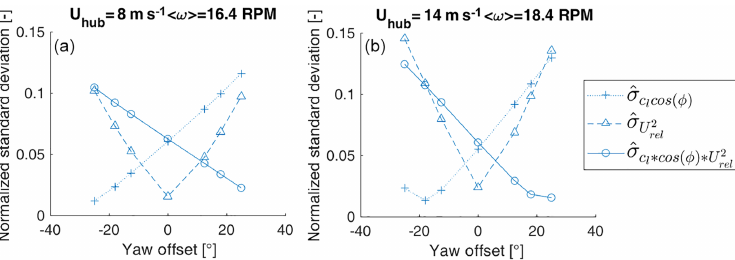
(triangles), and their product (circles) for the airfoil at ∼ 75% of the blade span for Figure 3. Standard deviations of c l cos φ (crosses), U 2 rel two U hub wind speeds of 8ms − 1 (a) and 14ms − 1 (b) , wind shear exponent value of 0.2, and mean rotor rotational speed of ω = 16 . 4 (a) and 18rpm (b) . The standard deviations are normalized by the means of the respective arguments.